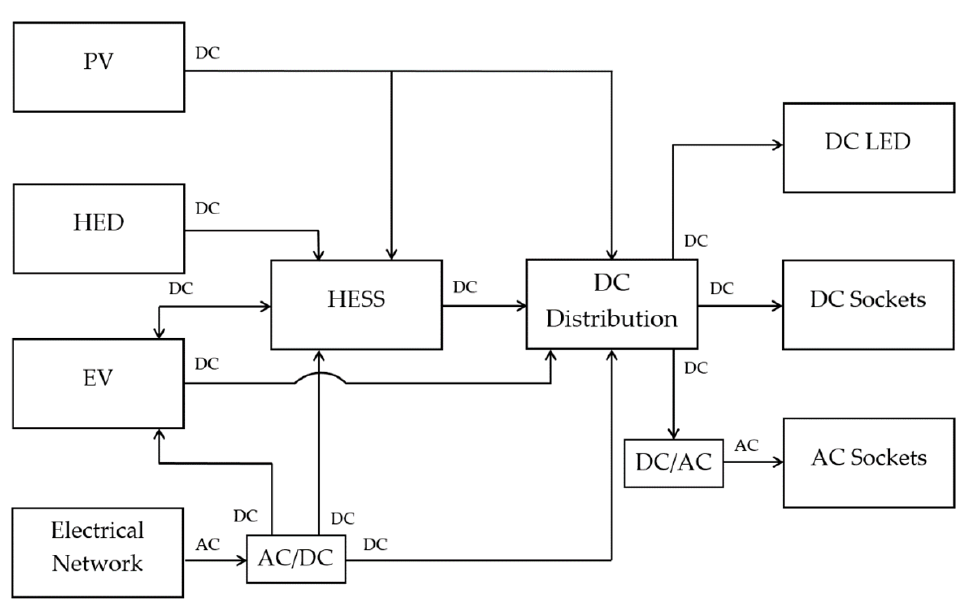
Figure 11. Block diagram of the DC distribution scenario with PV, HED, and EV.